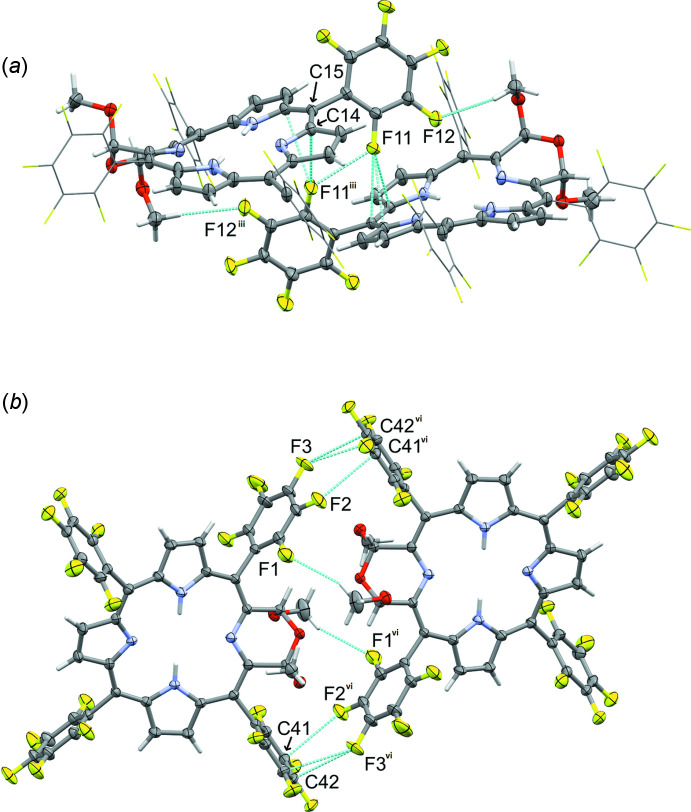
F⋯F, C—F⋯π and C—H⋯F inter­actions (turquoise dashed lines) connecting mol­ecules into dimers. Penta­fluoro­phenyl groups not involved in the shown inter­actions are shown in wireframe mode for clarity. For symmetry codes, see Table 1 ▸.